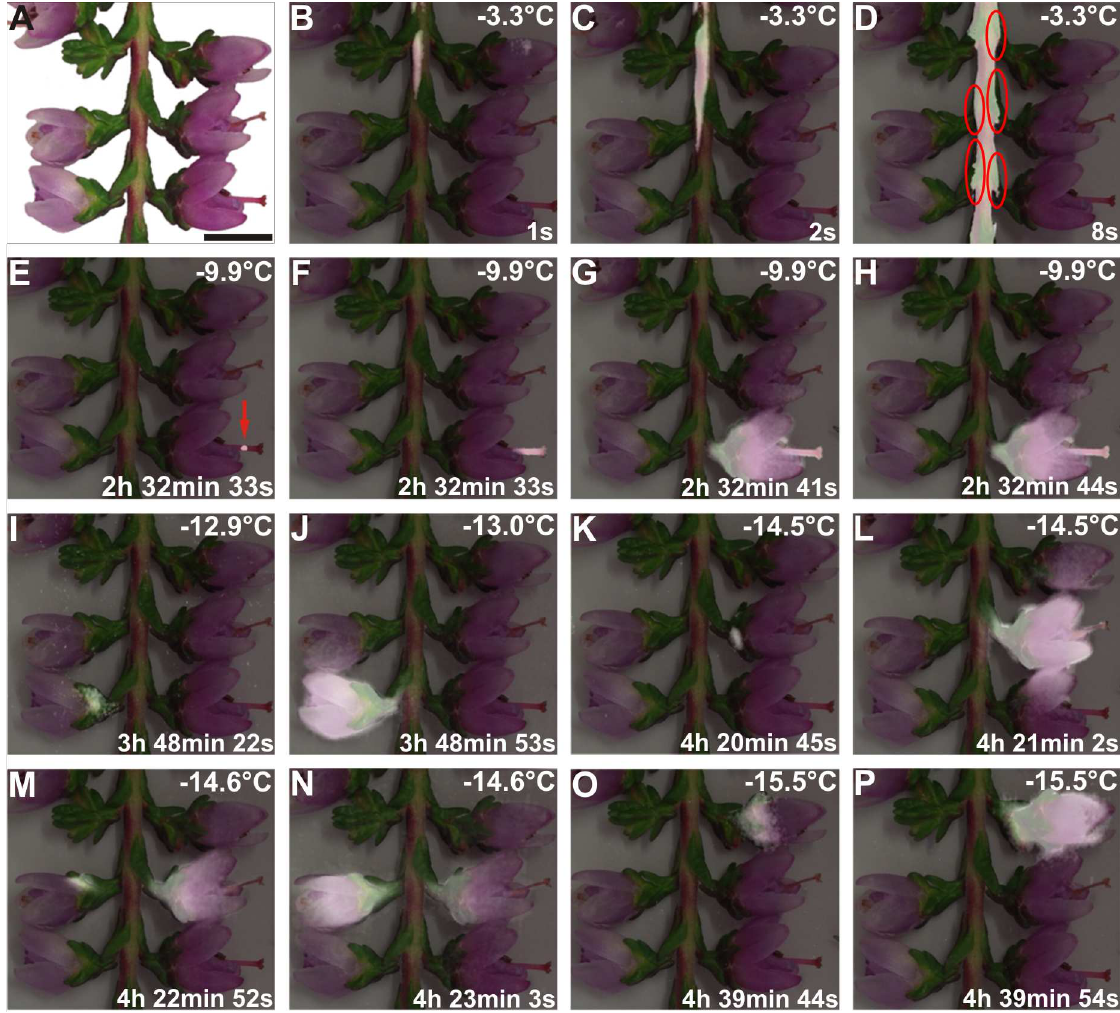
Fig 2. Locationof the ice barriertissueby IR-Thermography. (A) Digitalimageof a vegetative shoot bearingfive reproductive shootsof C . vulgaris priorto the freezingtreatmentand (B-P)sequenceof imagesof an overlay of the digitalimage and of IDTA imagesduringcontrolledfreezing.Heat given off by freezingis white in comparisonto the background. Ice nucleated at -3.3°Cin an INA bacteriasuspension droplet(not in the picture)that had been placed at the cut end of the vegetative shoot and passed immediately into the vegetative shoot (B-D).The structuralice barrieris clearlydetectable at the base of the pedicel (D, red circles).All flowers remainedsupercooled and froze at lower temperatures between -9.9°Cand -15.5°C, about2.5 h and 4.7 h laterthan the initialice nucleationin the vegetative shoot. In one flower the initialice nucleation event was detectedin the style (E, red arrow),and ice propagated fromthereinto all otherreproductive organs(F-H).The otherfour flowers showed initialice nucleation in the regionof the calyx, base of the petals or the gynoeceum (I, K, M, O). Afternucleation in the flowers ice propagated downwards and stoppedat the base of the pedicels(I-P).Actual temperatures are indicatedin the top rightcornerof each image. The timespan (in hours, minutes, and seconds) afterinitialice nucleation in the vegetative shoot is indicatedat the bottomrightcornerof each